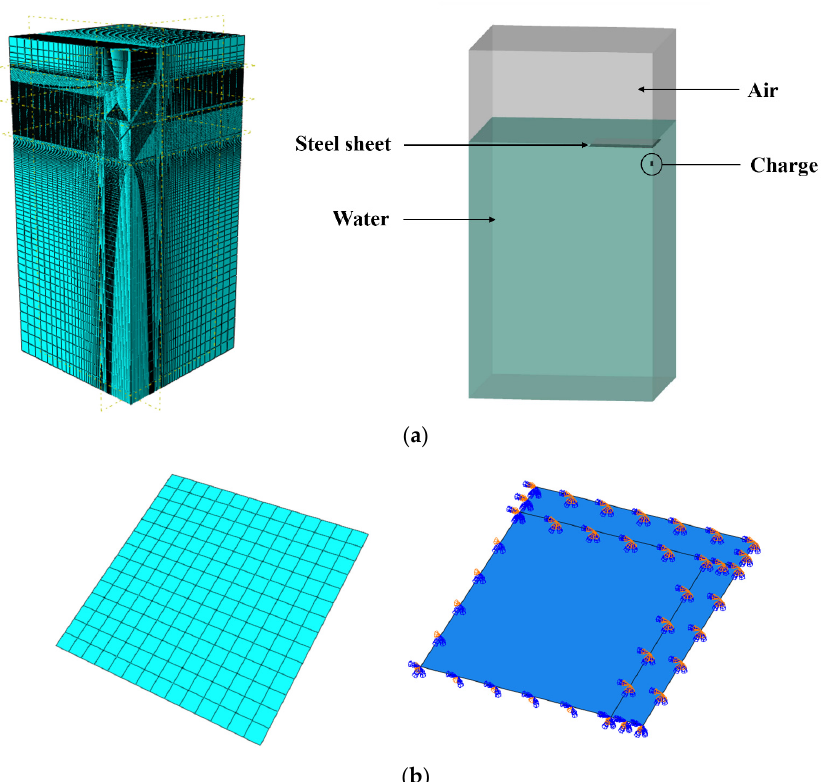
Figure 11. FE model of underwater explosion tests. ( a ) Eulerian elements (air, water, and charge). ( b ) Steel sheet.